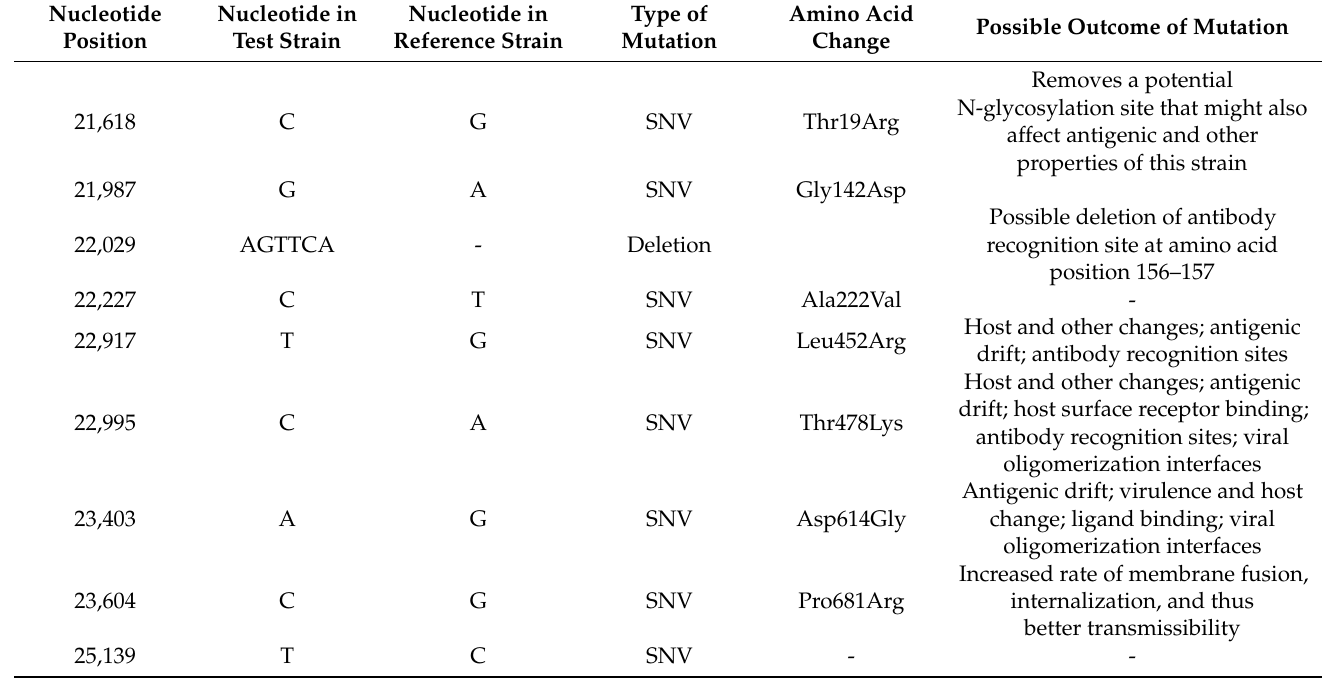
Table 5. Effects of the mutations observed in the sequence of the spike (S) protein of one SARS-CoV-2 genome from a dog (sample ID: A4N) in comparison to the reference